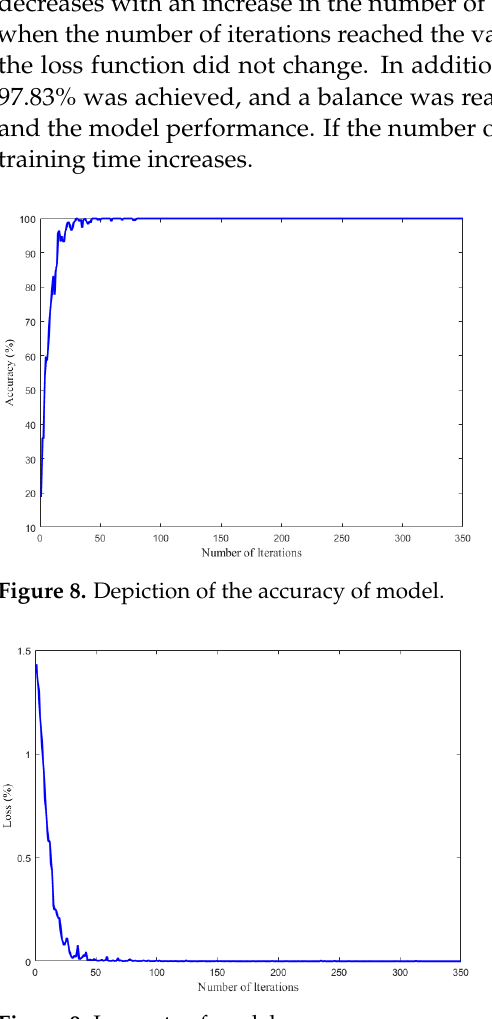
Figure 9. Loss rate of model.